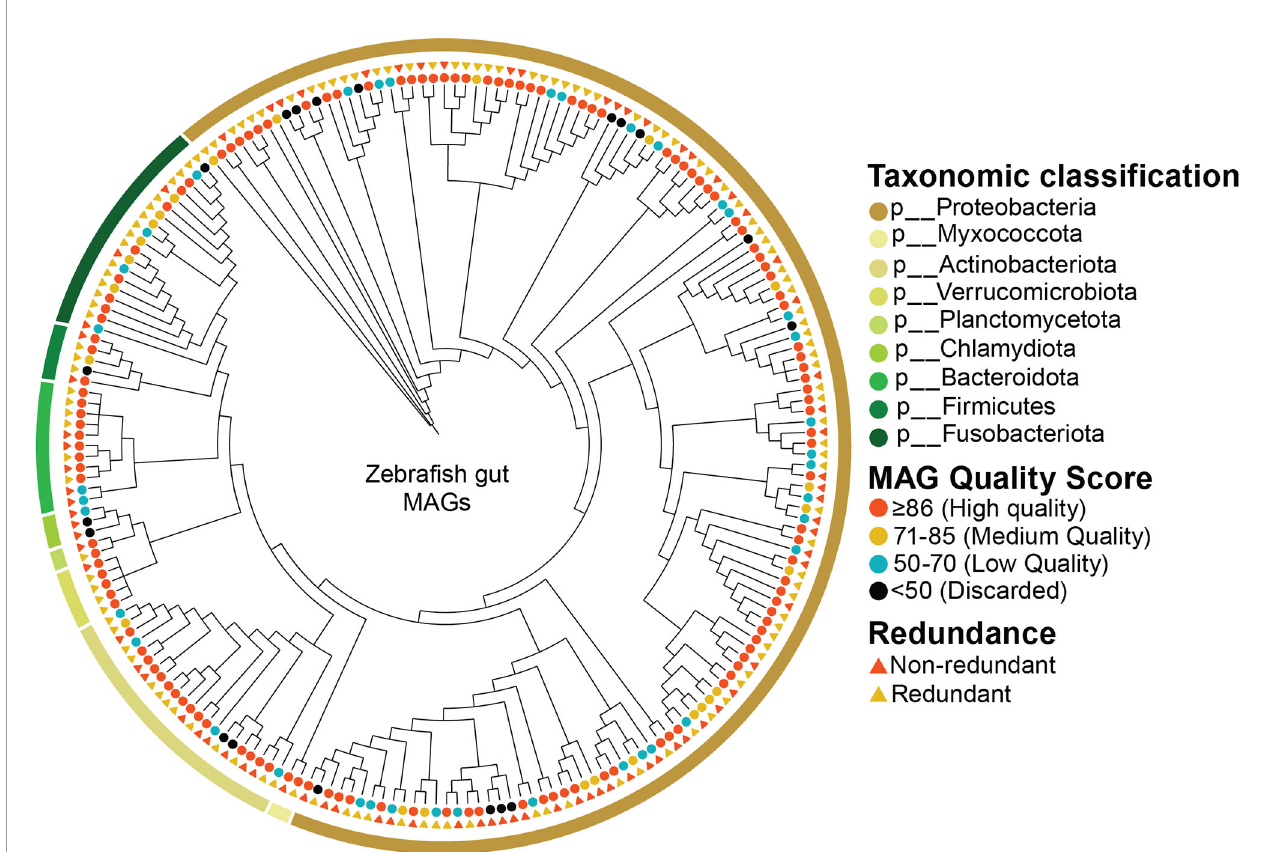
FIGURE 1 | Taxonomic classi fi cation and general characteristics of MAGs identi fi ed from the zebra fi sh stool microbiome. The outer ribbon demonstrates the taxonomic classi fi cation (performed using GTDB-tk) of MAGs at the Phylum level, which shows that most MAGs belonged to the phylum Proteobacteria. MAG quality scores are shown through the circles, suggesting that most of the MAGs were High- or Medium Quality, whereas MAGs with scores less than 50 were discarded from further analysis. The quality scores were inferred from the MAGs completeness and contamination levels calculated using CheckM. Lastly, the redundancy between the zebra fi sh stool MAGs is shown using the triangles. MAGs were considered redundant if they shared more than 95% whole-genome